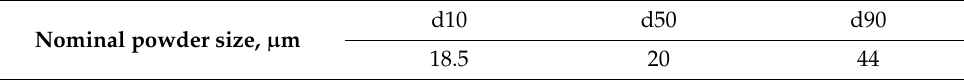
Table 1. Nominal composition of Inconel 718 powder used in this work.